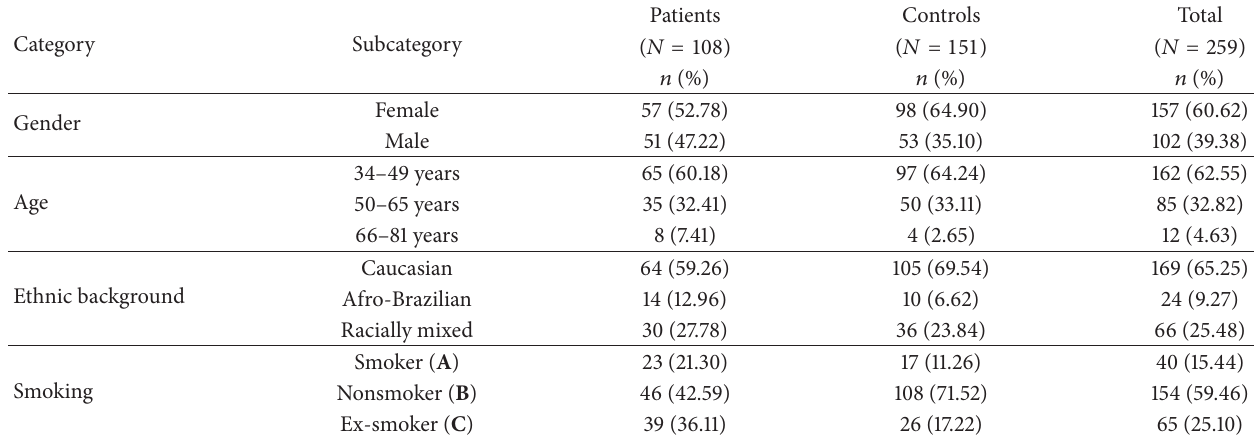
Table 1: Characteristics of patients with chronic periodontitis and controls.